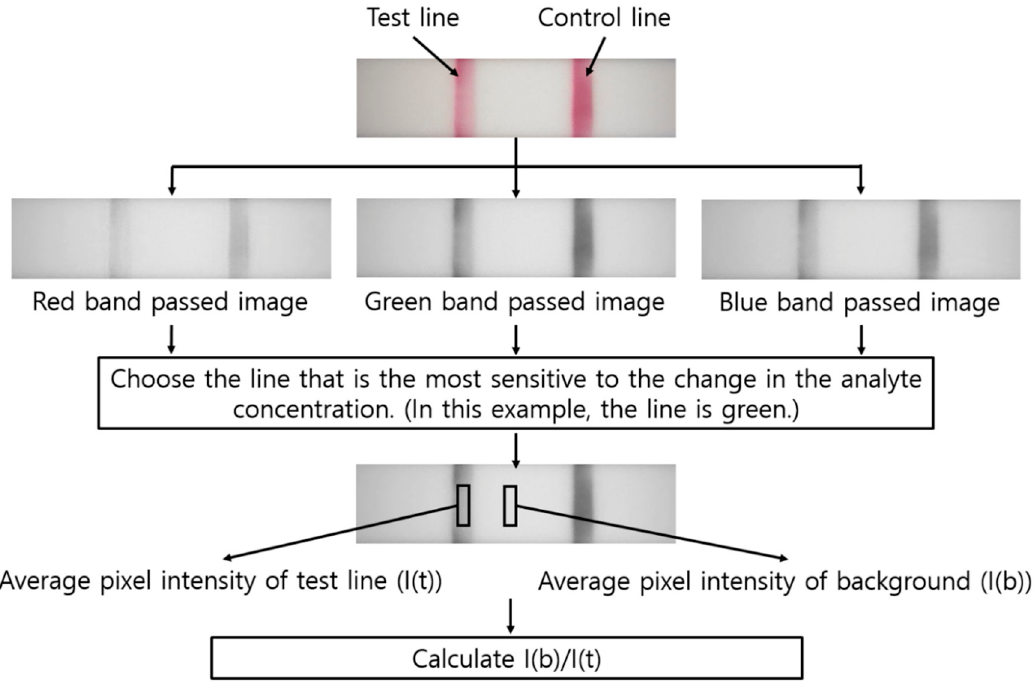
Figure 3. Analysis process of the color images for LFIA quantification. The control line captures any particle passing through, and thereby is used to ensure the proper sample flow in an LFIA. Only the test line area was analyzed.